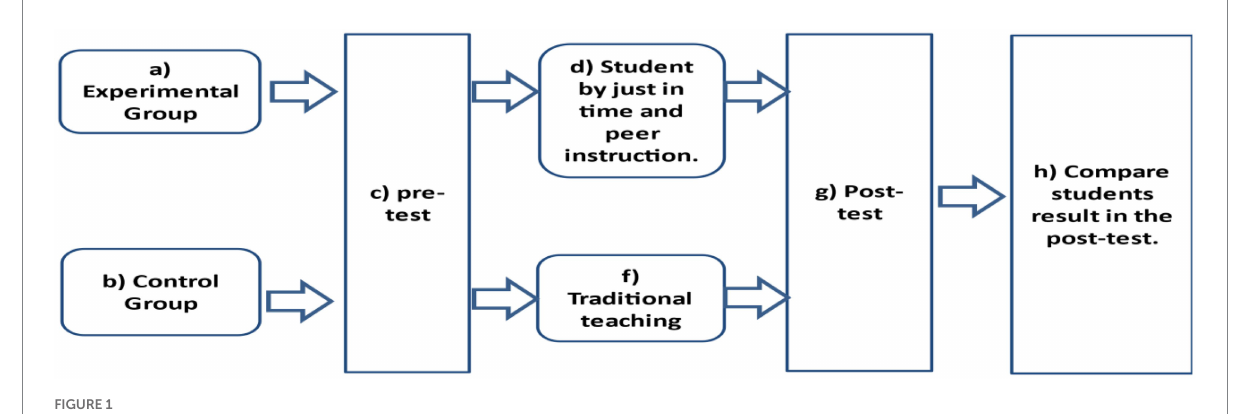
FIGURE 1 Stages of data